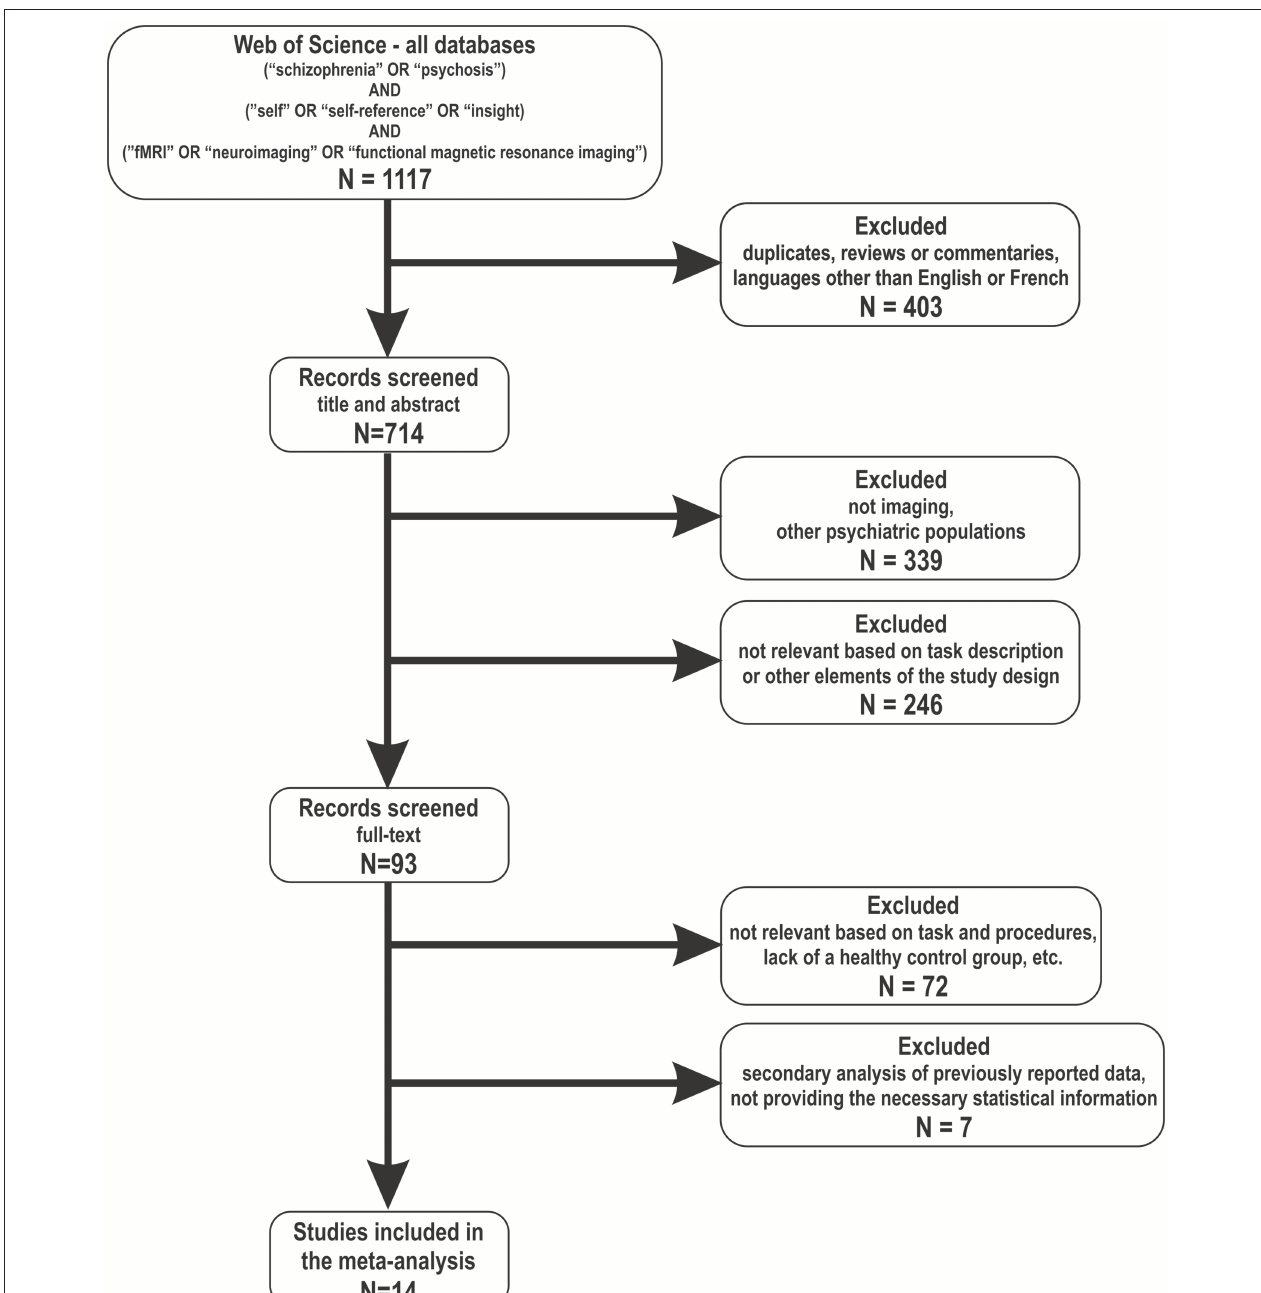
FIGURE 1 | Flow chart of the articles included in the meta-analysis.